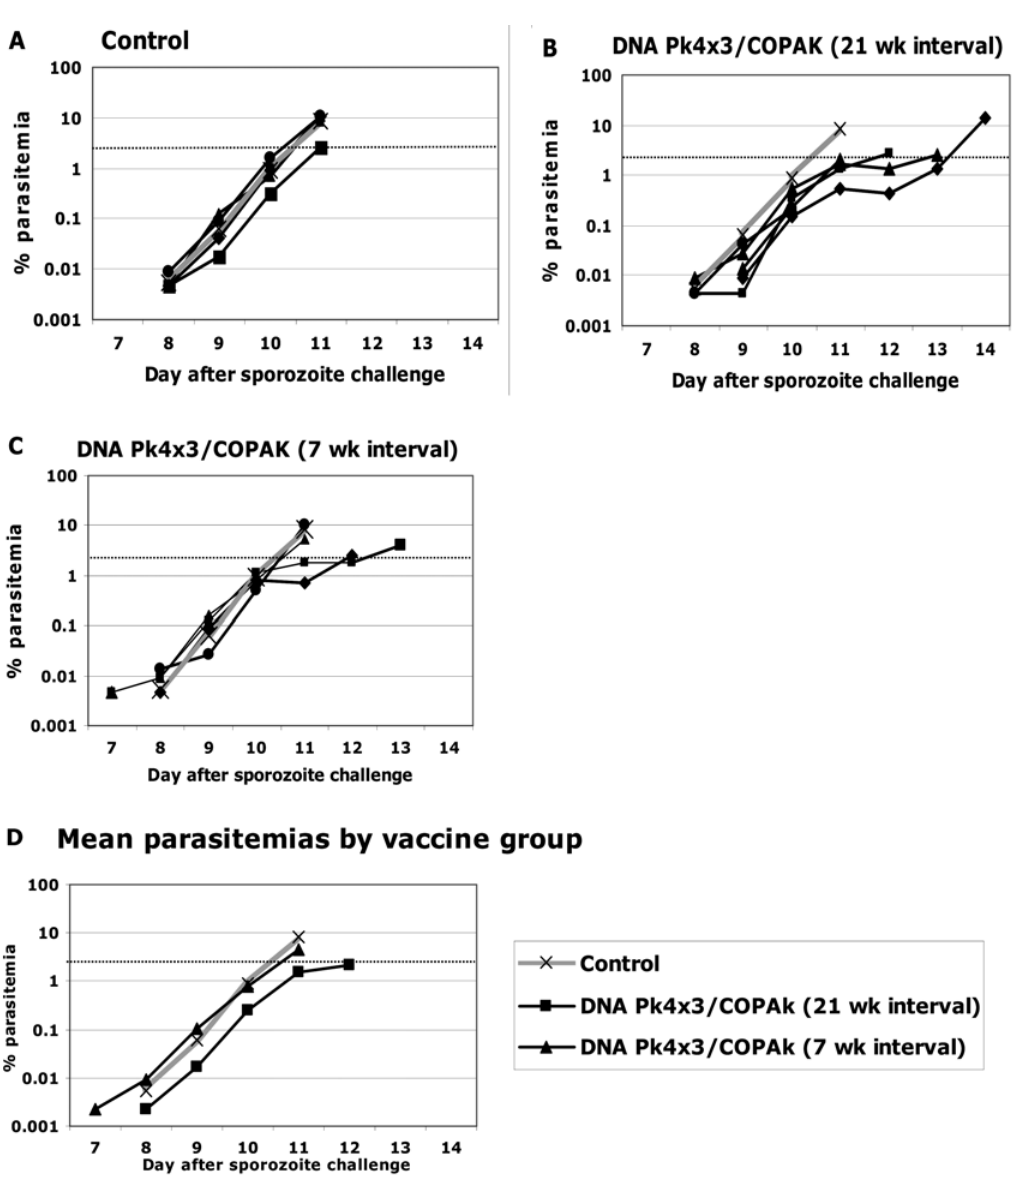
Figure 5. Panels A–C show the % parasitemias for individual monkeys by vaccine group according to the day after sporozoite challenge for Experiment # 3. Data shows the first day parasites were detected and continues until the animal was treated with anti-malaria drugs. For comparison, in each panel the grey line shows the mean parasitemia for the Control group. Panel D shows the geometric mean parasitemias for all the vaccine groups for all days in which at least three animals had not been drug treated. For each day 8–11 the mean parasitemia for the group receiving the booster dose at the 21 week interval was lower than the other groups (p , 0.05, Student’s T test).